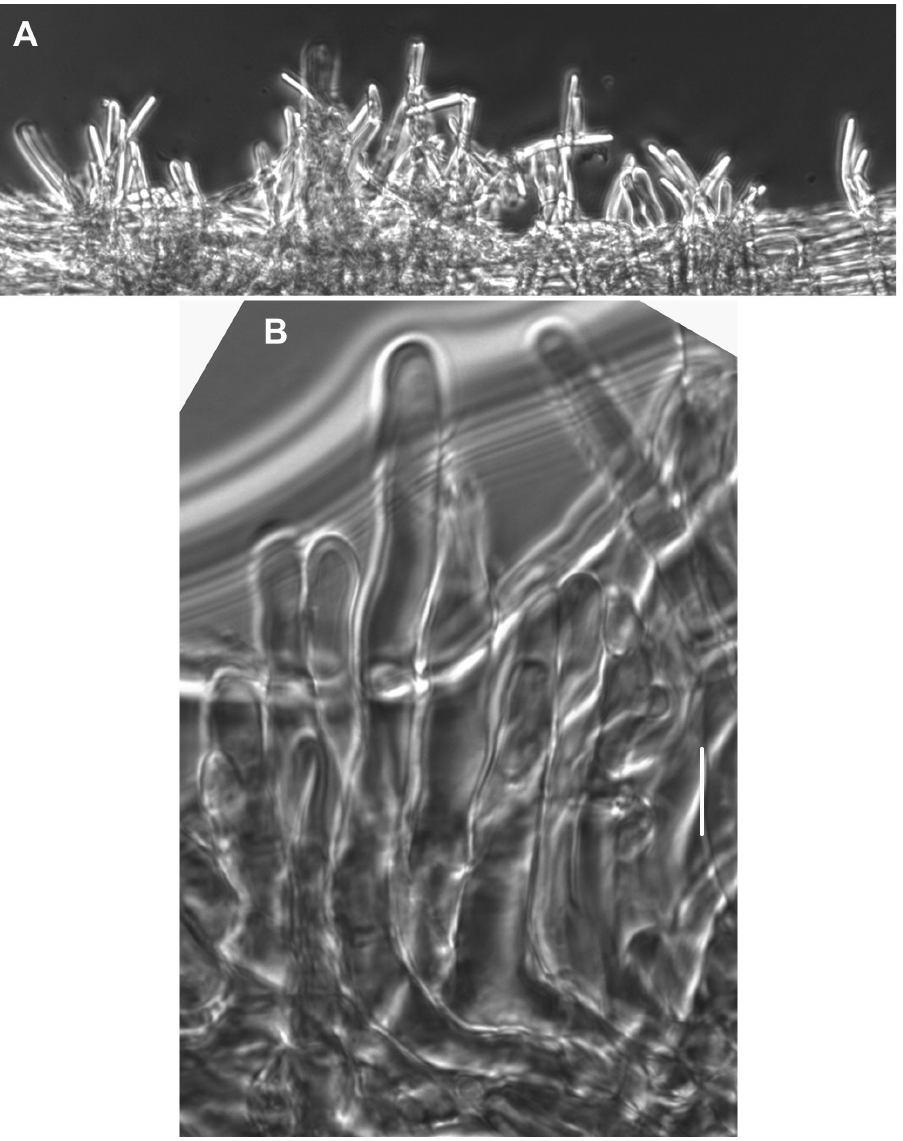
Figure 48. Mycetinis olidus . Caulocystidial structures. A Arrangement of caulocystidia on stipe surface B Caulocystidia. A = not to scale. B Standard bar = 10 µm. VA 97 257 (TENN 50012). of M. prasiosmus is quite different from the European organism treated here as M. pra- siosmus , in which the color reaction is